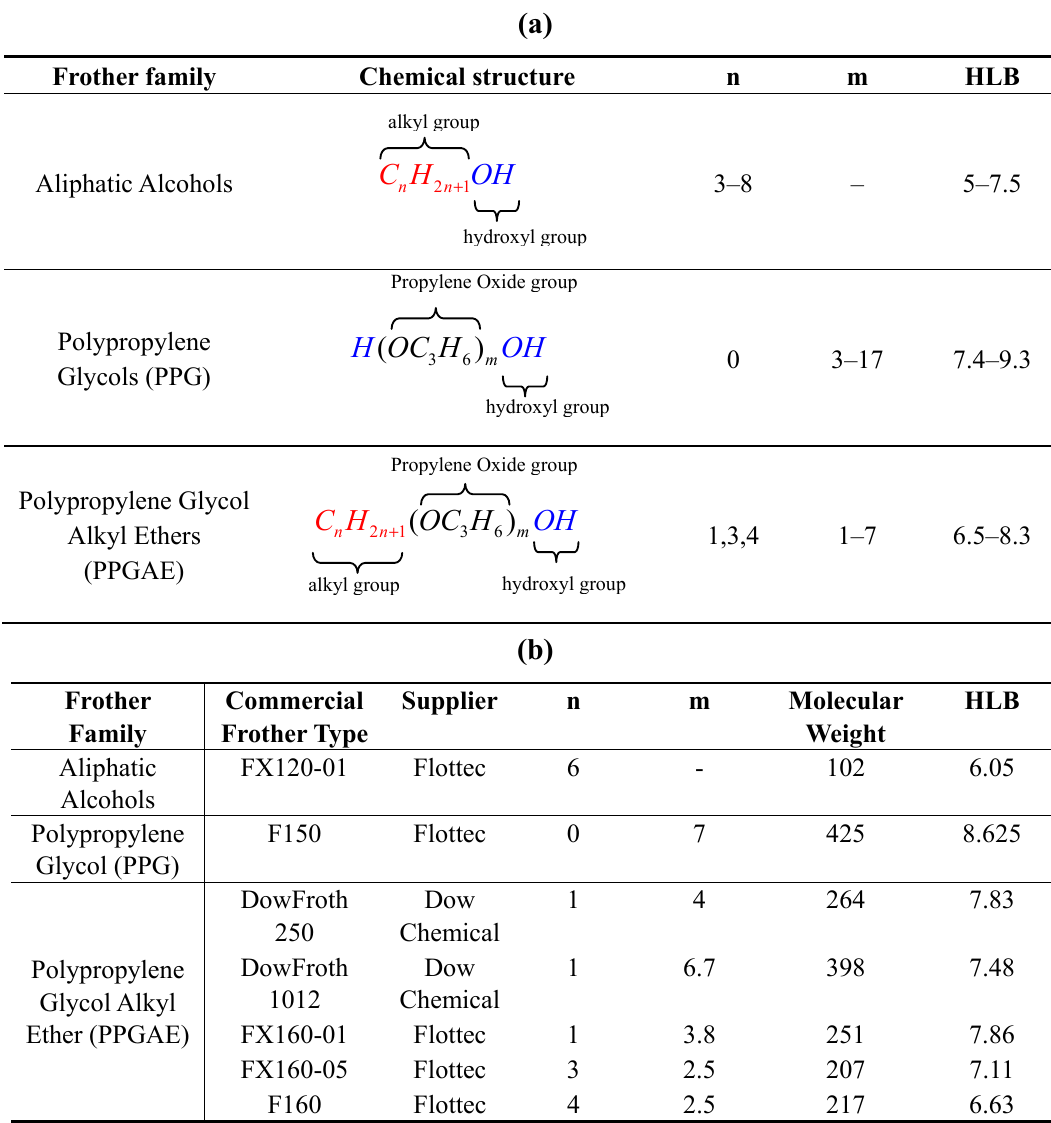
Table 3. ( a ) Frother families and range of surfactants (n, m and HLB) used in the study; ( b ) Commercial frothers used in the